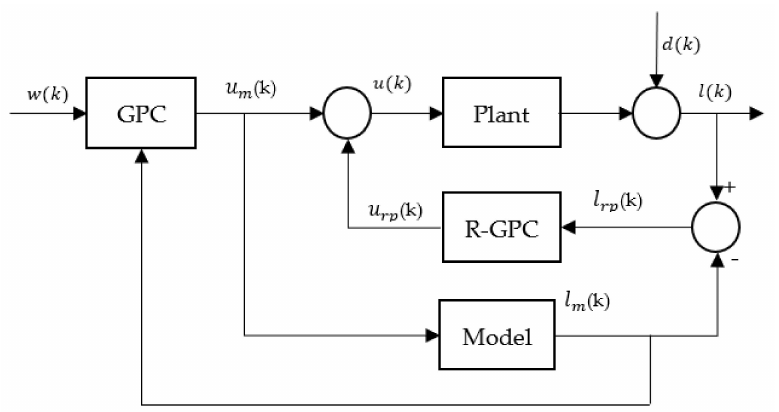
Figure 7. Block diagram of the repetitive structure used in the mold level control